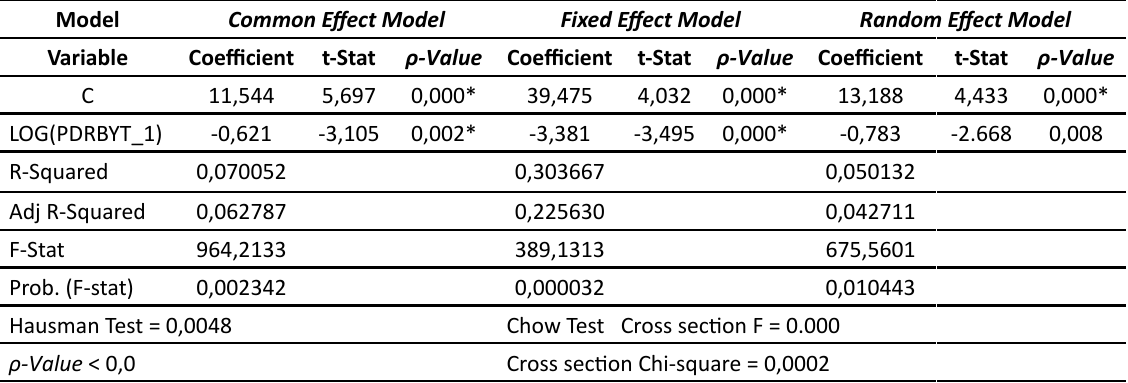
Table 1: Results of Absolute Beta Convergence Estimation in Districts/Cities of South Kali - mantan